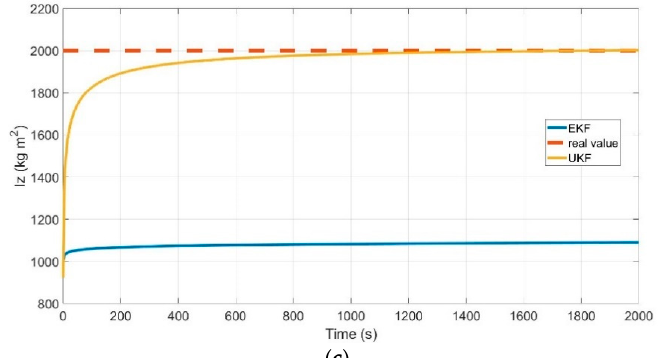
Figure 7. Second stage VDPs estimation. ( a ) the tire cornering stiffness estimation ( b ) the moment of inertia around the longitudinal axis estimation ( c ) the moment of inertia around the yaw axis estimation.